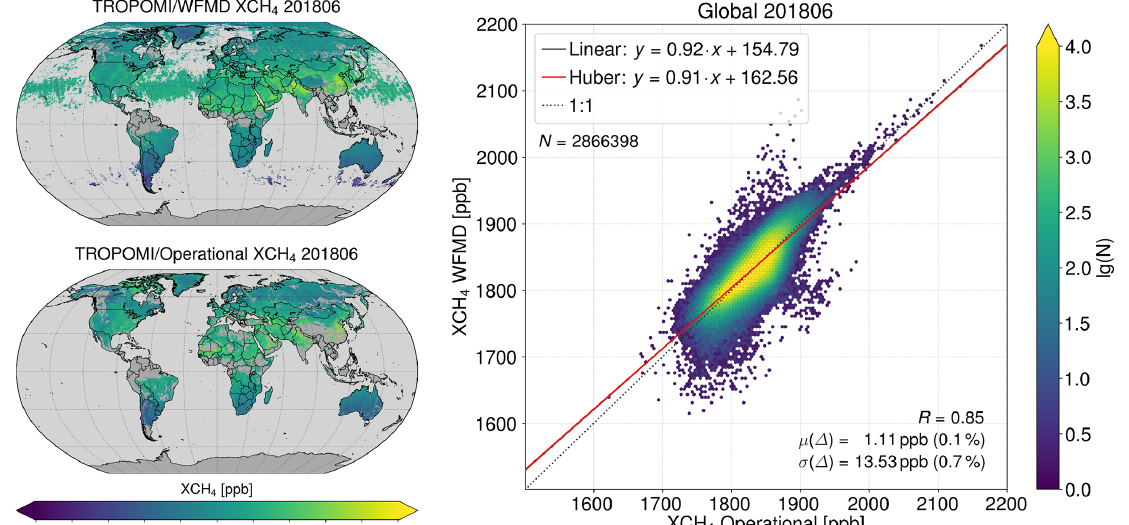
Figure 17. As Fig. 16 but for June